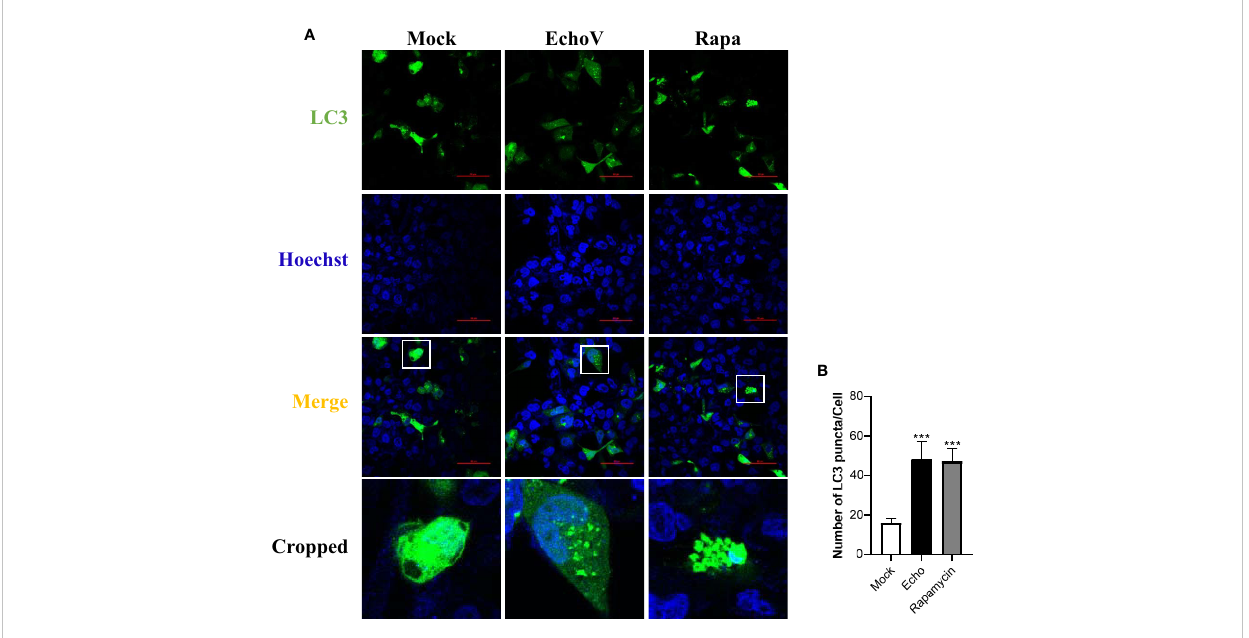
FIGURE 3 Echovirus infection increases the level of LC3 puncta formation. RD cells were transfected with GFP-LC3 plasmid for 24 h, followed by infected or not (Mock) with echovirus 11 at 1 MOI for 1.5 h. (A) At 16 h post-infection, cells were fi xed and analyzed by confocal fl uorescence microscopy. RD cells were treated with rapamycin (500 nM) (Rapa) for 16 h as a positive control. (B) Quantitation of the numbers of LC3 puncta in RD cells. Data shown represent the number of LC3 puncta per cell under each condition. A one-way ANOVA was used to determine statistically signi fi cant differences in multiple comparisons. *** P <0.001.